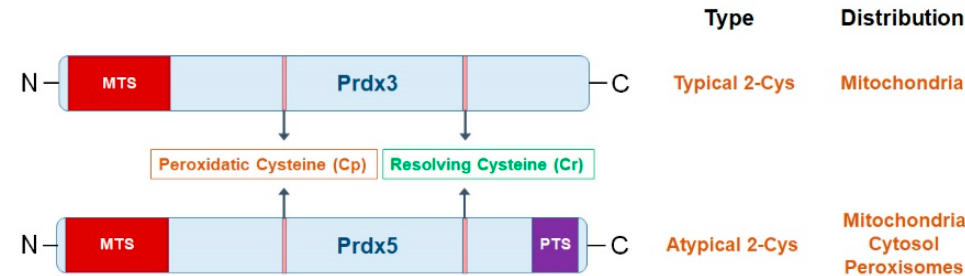
Figure 2. Structural comparison of mitochondrial peroxiredoxins (Prdxs). Peroxiredoxin 3 (Prdx3) and Peroxiredoxin 5 (Prdx5) contain a mitochondrial targeting sequence (MTS) at their amino terminal (N-terminal) and this enables them to reside in the mitochondria. Prdx5 in addition to MTS also contains a peroxisomal targeting sequence (PTS) at its carboxyl terminal (C-terminal) that is responsible for the entry of Prdx5 in the peroxisomes. Both mitochondrial Prdxs comprise peroxidatic cysteine (Cp) and resolving cysteine (Cr) which play an essential role in their catalytic mechanisms. In Prdx3, Cp is located at residue 47, whereas, in Prdx5, it is located at residue 48 [35].